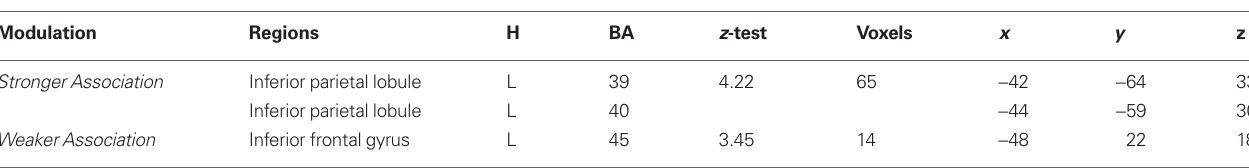
Table 3 | The effects of semantic association for related